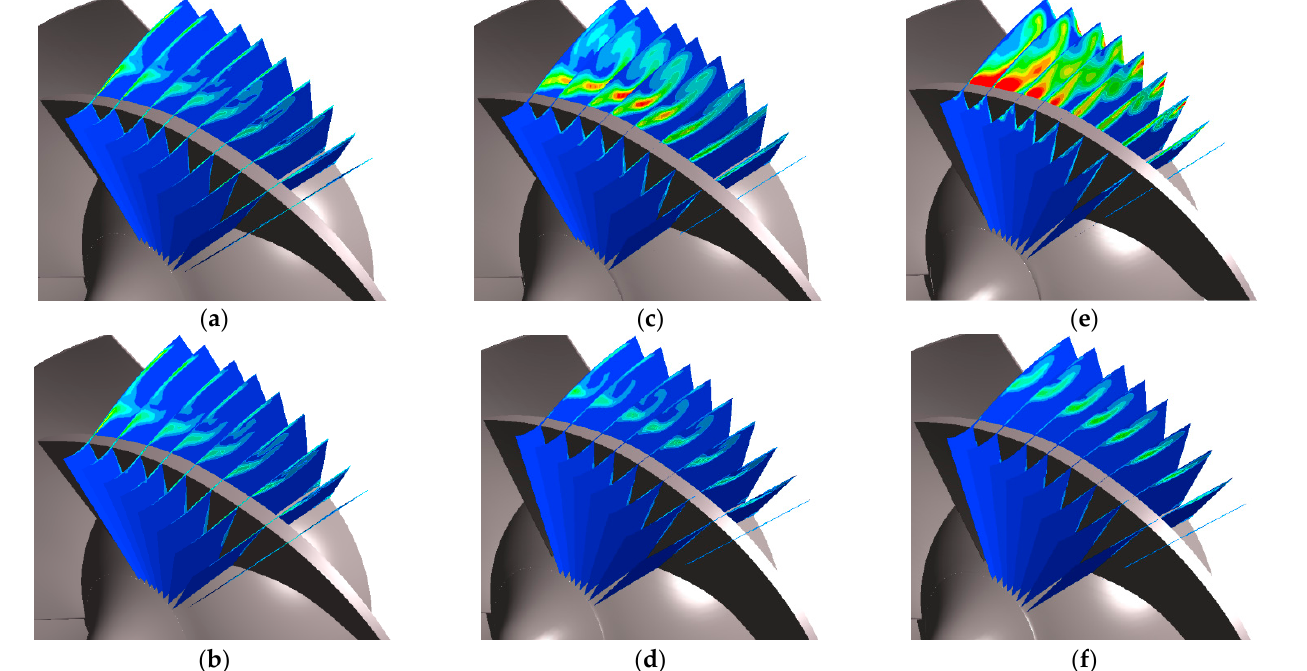
Figure 16. Distribution of gap L 1. ( a ) e = 0 mm, ( b ) e = 0 mm, ( c ) e = 3 × 10 − 1 mm (small gap), ( d ) e = 3 × 10 − 1 mm (large gap), ( e ) e = 5 × 10 − 1 mm (small gap), ( f ) e = 5 × 10 − 1 mm (large gap).